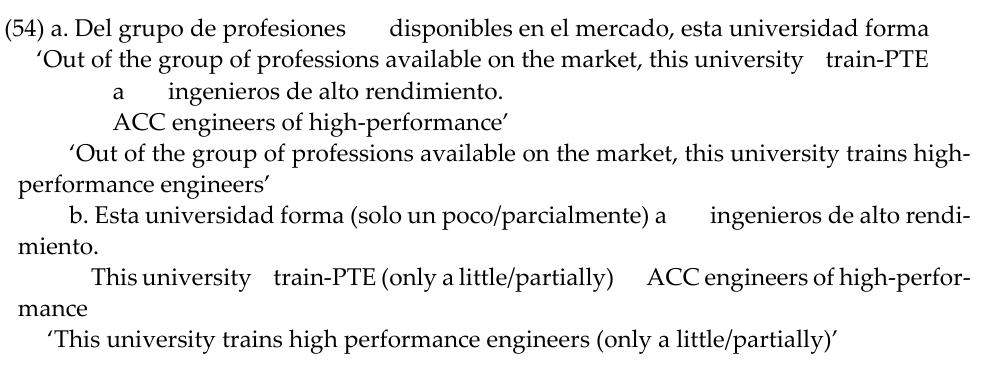
Figure 31. After insertion of v*, inheritance, Agree, and labeling.